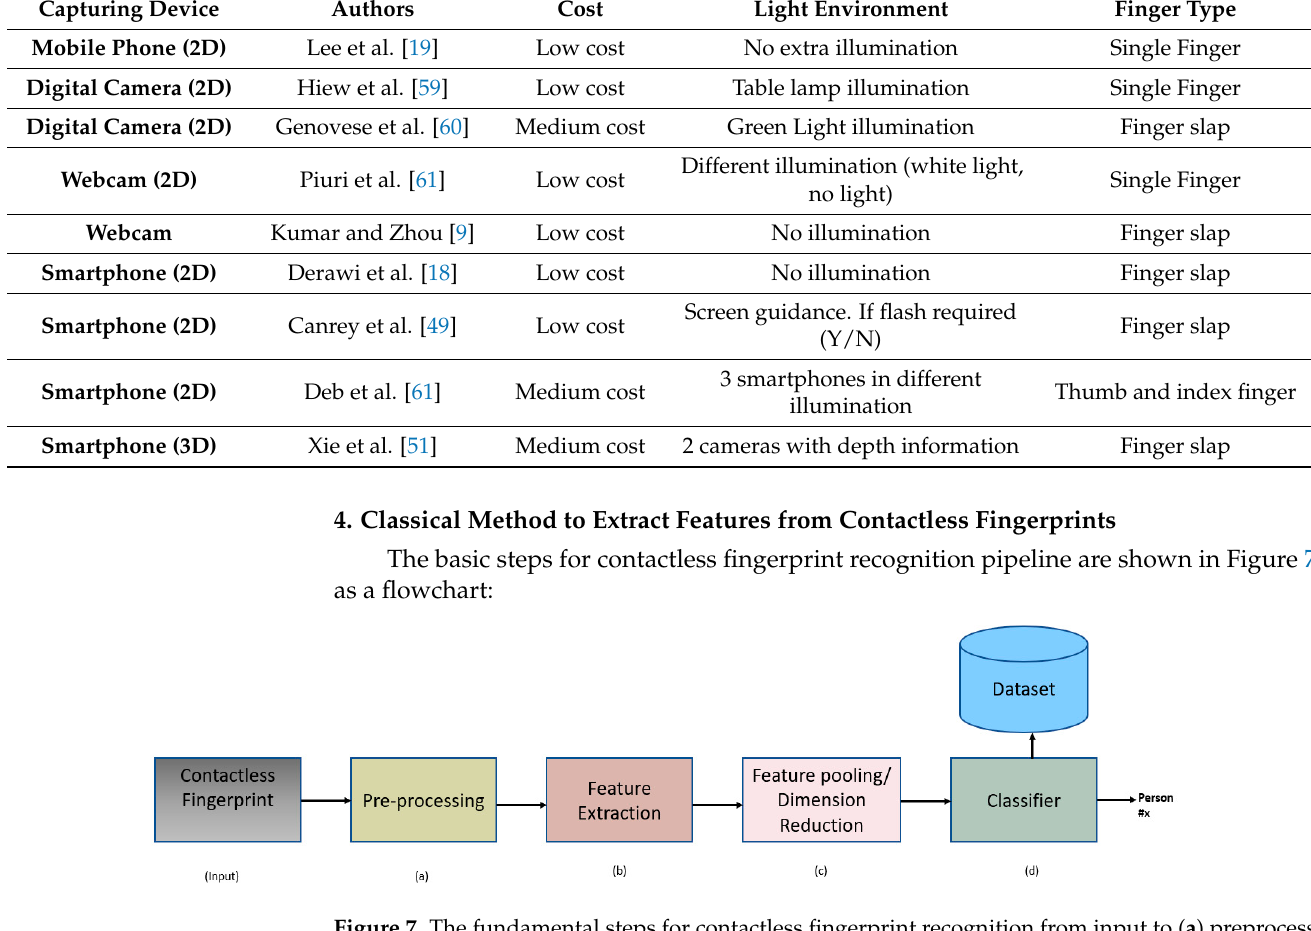
Figure 7. The fundamental steps for contactless fingerprint recognition from input to ( a ) preprocess the images; ( b ) Feature extraction ( c ) Dimension reduction; and ( d ) classified the person.